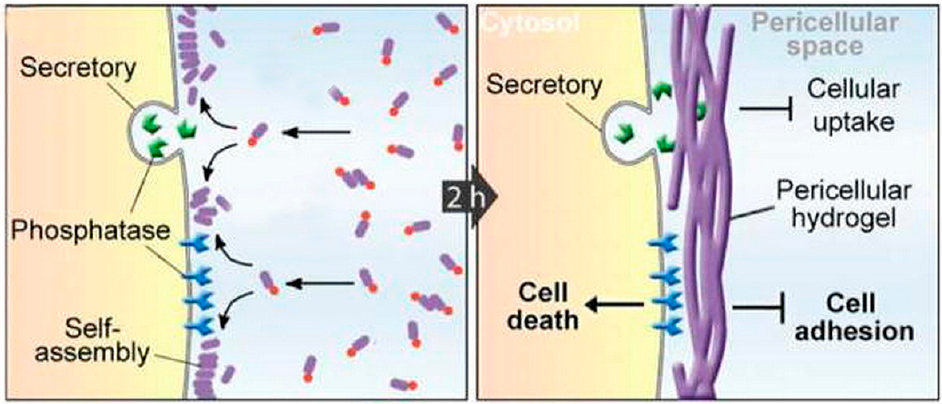
Figure 4. Enzyme catalyzed formation pericellular hydrogel/nanonets to induce cell death. Adapted with permission from ref. [75], Copyright © 2014 WILEY-VCH Verlag GmbH & Co. KGaA.